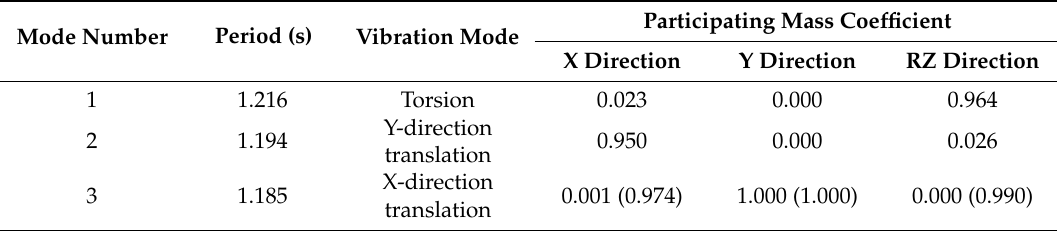
Table 6. Numerical results of dynamic characteristics.